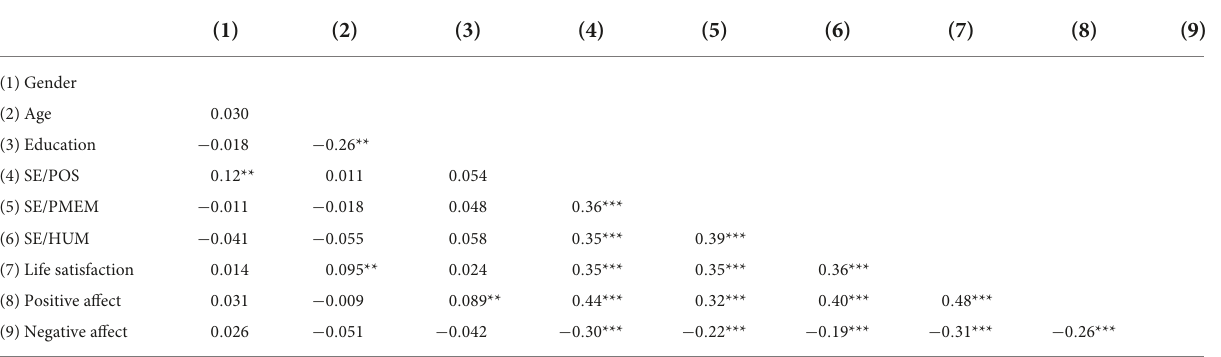
TABLE 4 Correlations among the socio-demographic variables, self-efficacy beliefs in managing positive emotions, and indicators of positive affect, negative affect, and life